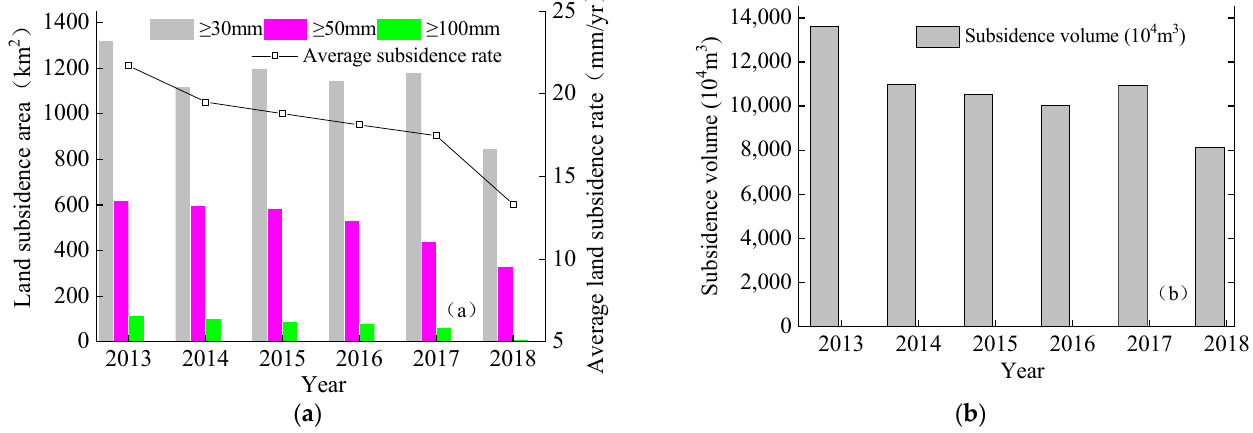
Figure 5. Statistics graphs of average subsidence rate, subsidence area, and volume (2013~2018). ( a ) Statistics of average land subsidence rate and subsidence area from 2013 to 2018. ( b ) Statistics of land subsidence volume from 2013 to 2018.